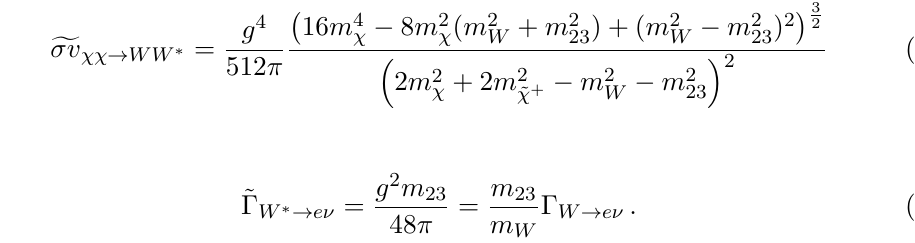
Figure 5 . Cross section for pure Higgsinos annihilating to W bosons, (cid:31)(cid:31) (cid:31)(cid:31) W (cid:0) e + (cid:23) . For the latter process, we show the cross section divided by the branching fraction ! (cid:0) W ! e(cid:23) = (cid:0) W 1 = 9 (solid lines). For comparison, we also include the model-independent estimate of ’ eq. (3.14) for (cid:31)(cid:31) W (cid:0) ( W + ) (cid:3) (dotted lines). For m (cid:31) . m W , the three-body cross section is clearly ! larger than the lowest-order result; above the threshold, on the other hand, the two agree exactly. than the neutralino, such that the only contributing diagrams are of the V = W (cid:0) ISR type, with a virtual Higgsino-like chargino and a resonance R = W + (cid:3) . In this limit, we